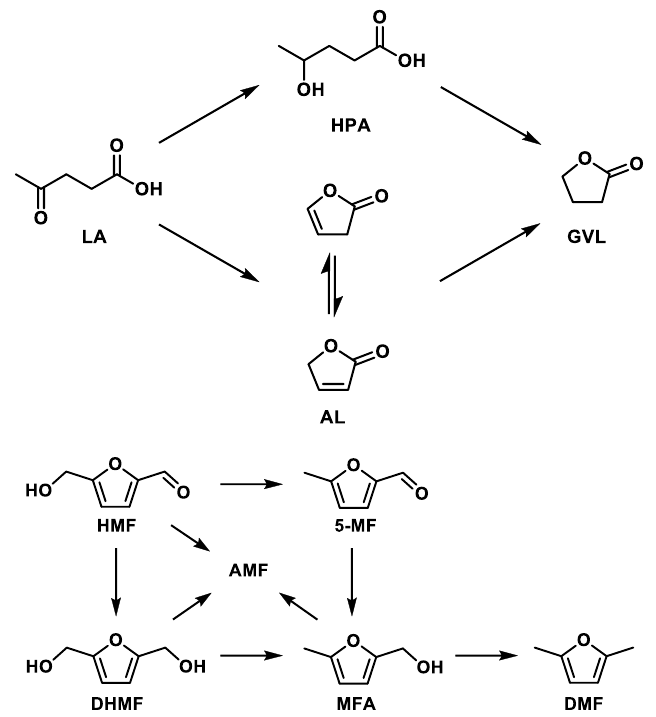
Figure 1. Typical Ru catalyzed reaction mechanism for (top) the conversion of levulinic acid (LA) to gamma valerolactone (GVL) and (bottom) the conversion of 5-hydroxymethylfurfural (HMF) in an alcoholic solvent.